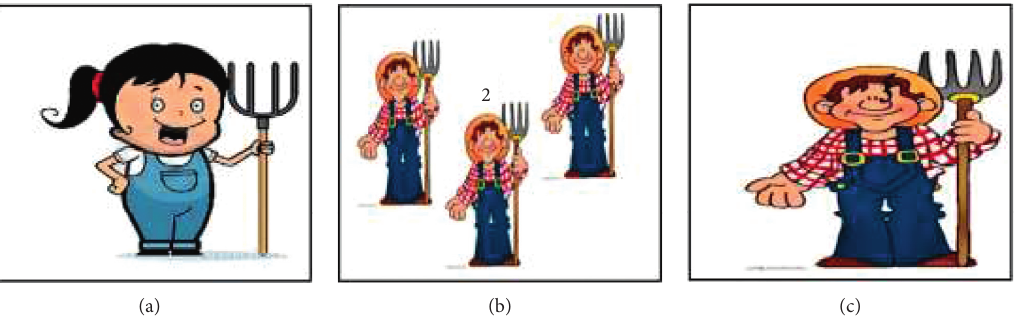
Figure 1: Comprehension task sample test items.